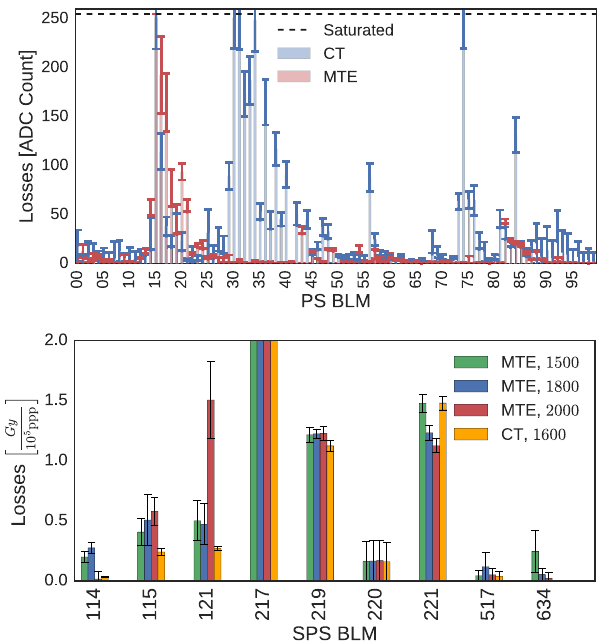
FIG. 22. BLM readings for MTE and CT in the PS (upper) and SPS (lower) rings. The bars represent the average, while the error bars the rms values of the BLMs. For the PS case the readings are given in ADC counts, while for the SPS, the readings have been normalized to the beam intensity. The typical intensity values are in units of 10 10 ppp at extraction from the PS.